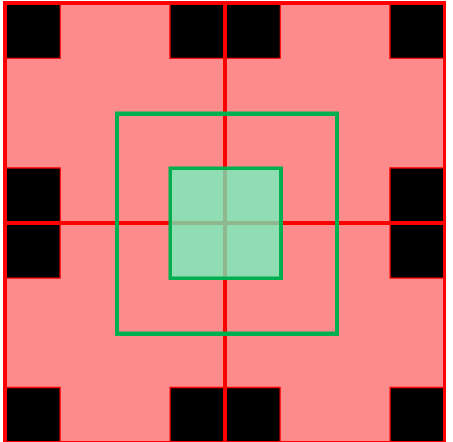
Figure 9. The red and green squares are the two overlapping 4 × 4 pixel patches used to cover the entire image. As the patches overlap, only the highlighted red and the green pixels from the red and green squares are used to estimate the